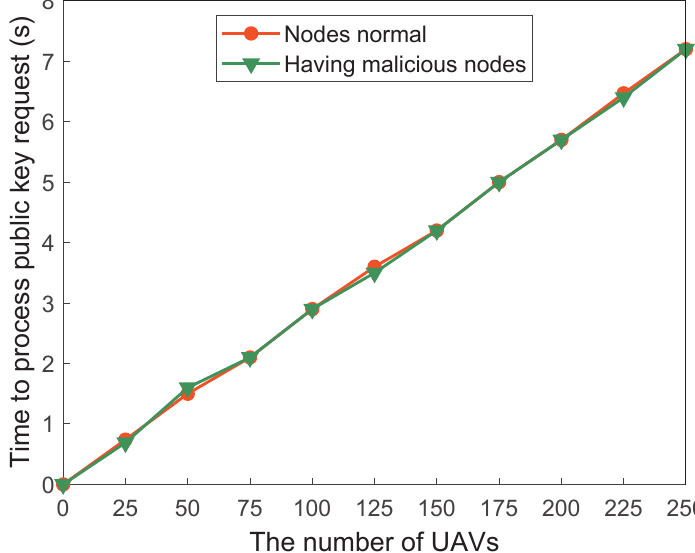
Figure 5. Public key request time according to the number of drones.